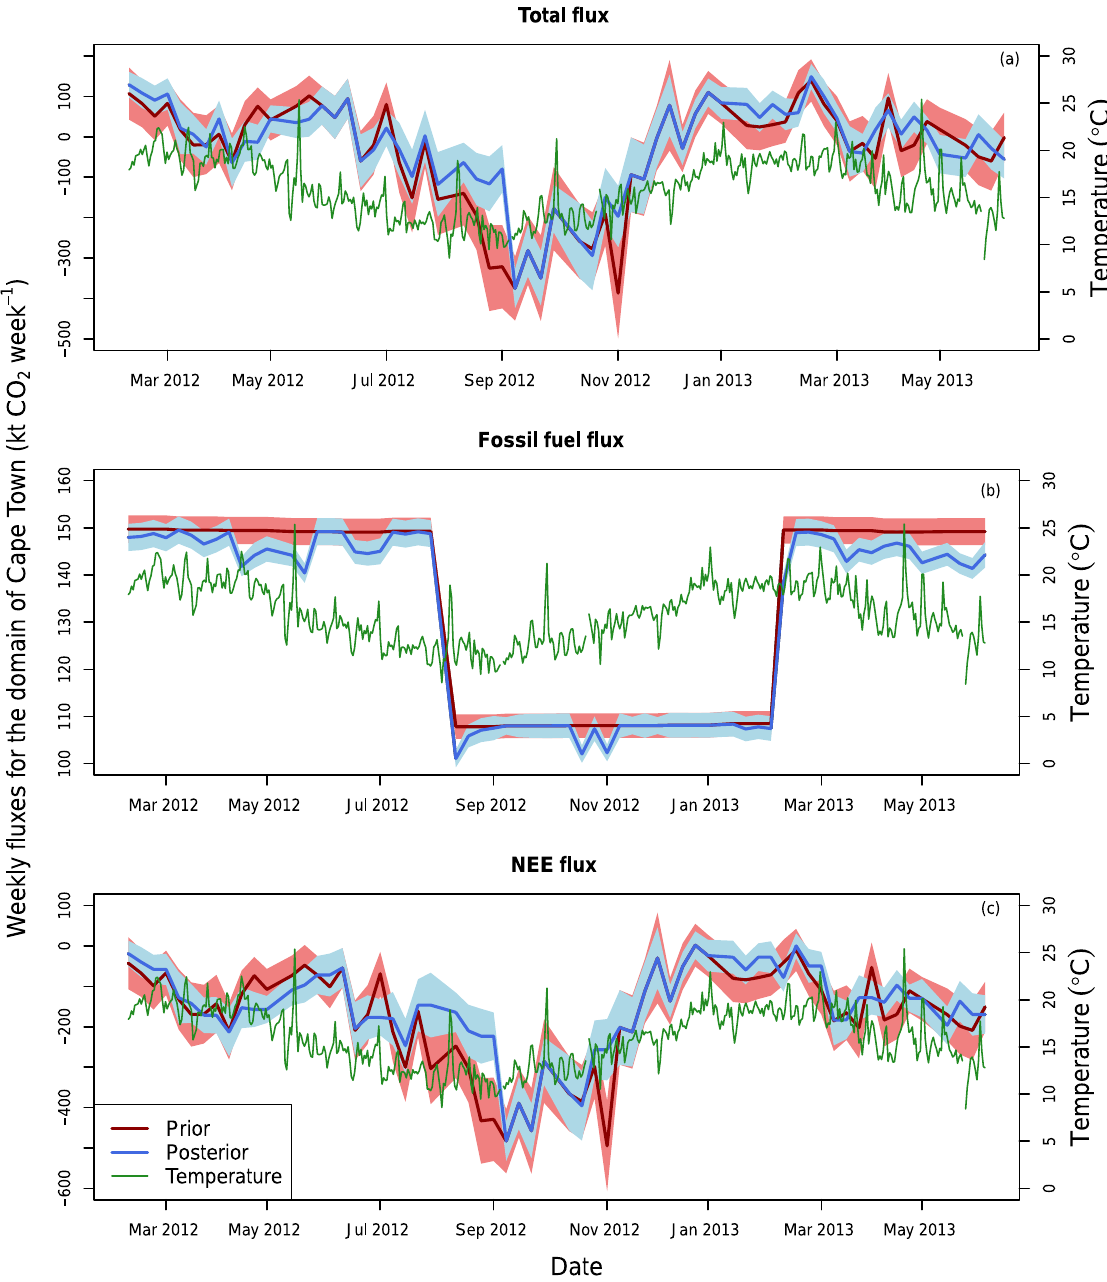
Figure 16. Prior (red) and posterior (blue) total weekly CO 2 flux estimates (kt CO 2 week − 1 ) (left axis) and uncertainty limits (shaded area), represented as a 95% confidence interval, across the full domain of Cape Town, shown as (a) the total flux, (b) the fossil fuel flux, and (c) the NEE flux. The daily temperature ( ◦ C) as recorded at the Cape Point GAW station is provided by the lower green line (right